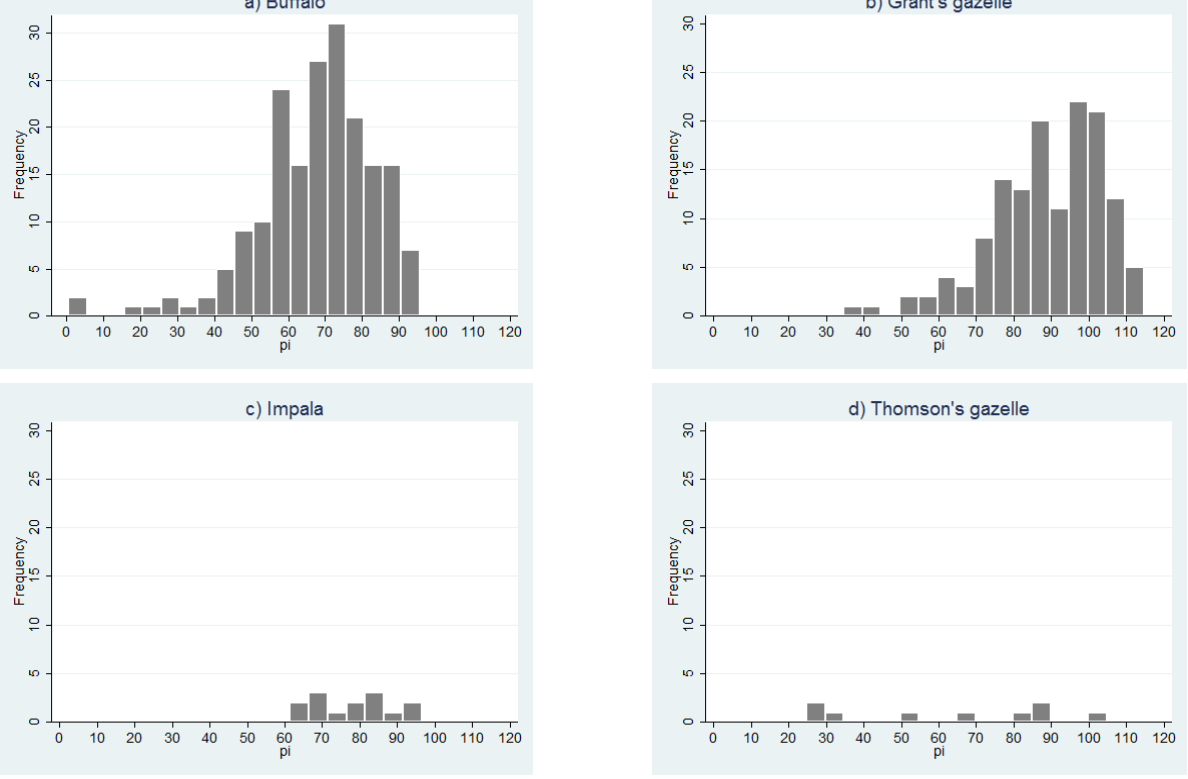
Figure 7. Distribution of peste des petits ruminants virus competitive enzyme-linked immune scheme 2018. ( a ) African buffalo; ( b ) Grant’s gazelle; ( c ) impala; ( d ) Thomson’s gazelle .